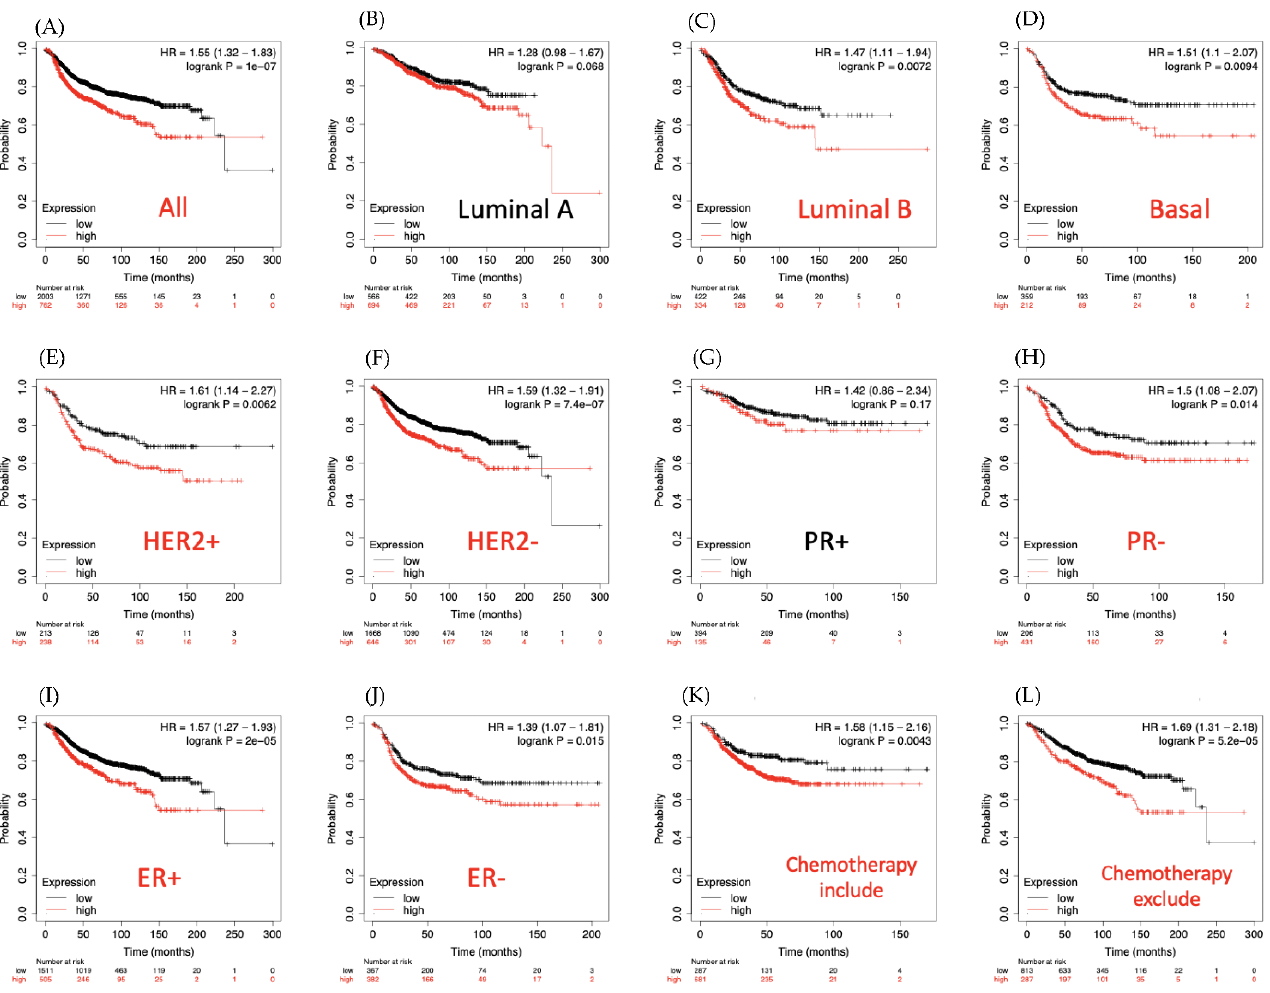
Figure 7. L-antigen 2B (LAGE2B) expression and distant metastasis-free survival (DMFS) of clinical breast cancer patients through survival analysis ( n = 2898). Kaplan-Meier graphs were plotted based on LAGE2B mRNA expression levels and showing the DMFS prognoses of breast cancer patients. ( A ) Overall survival, (B) Luminal A subtype, ( C ) Luminal B subtype, ( D ) Basal subtype, ( E ) HER2 + subtype, ( F ) HER2 − subtype, ( G ) PR + subtype, (H) PR − subtype, ( I ) ER + subtype, ( J ) ER − subtype, ( K ) survival analysis for chemotherapy-treated patients and ( L ) chemotherapy untreated patients. For two groups of patients based on the best cutoff value of LAGE2B mRNA and coloring the groups red and black, an auto-cutoff function was applied. High expression of LAGE2B was highly correlated with poor survival outcomes of breast cancer patients ( p < 0.05 was considered statistically significant).